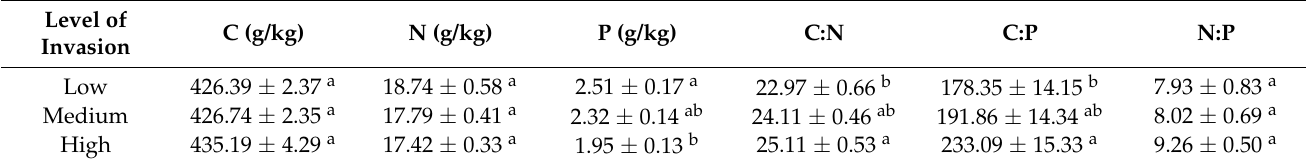
Table 4. Nutrient characteristics of aboveground parts of Pedicularis kansuensis among different invasion